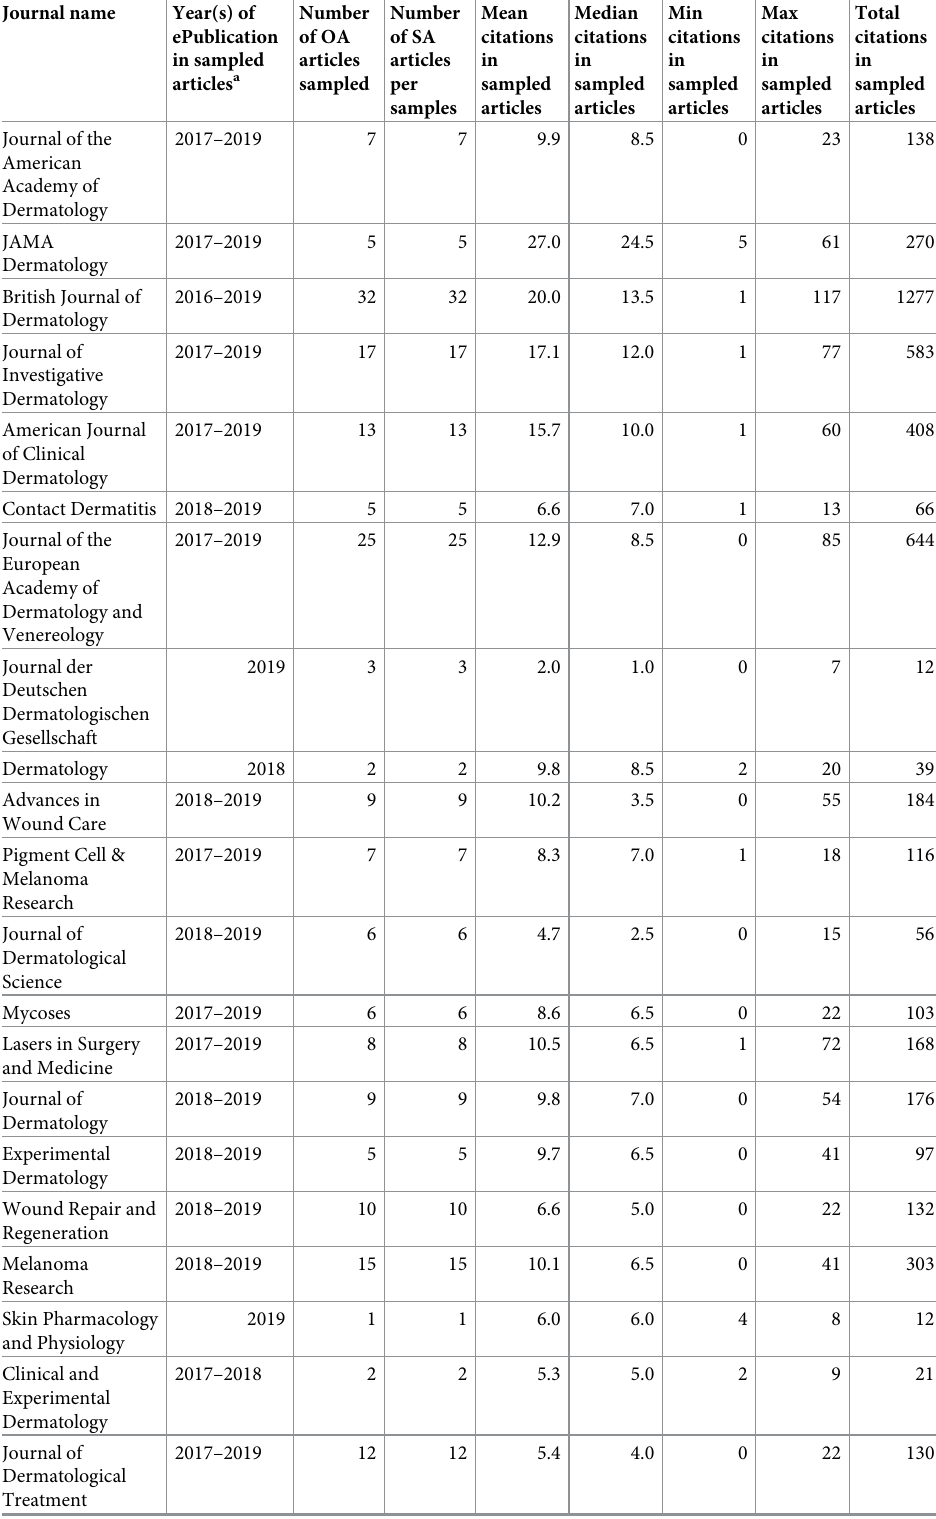
Table 2. Breakdown of citations in sampled articles by